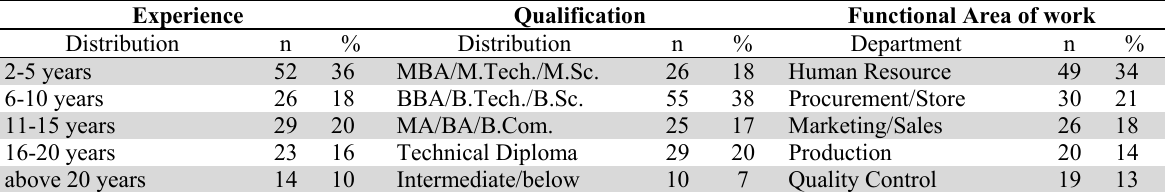
Demographic distribution of respondents